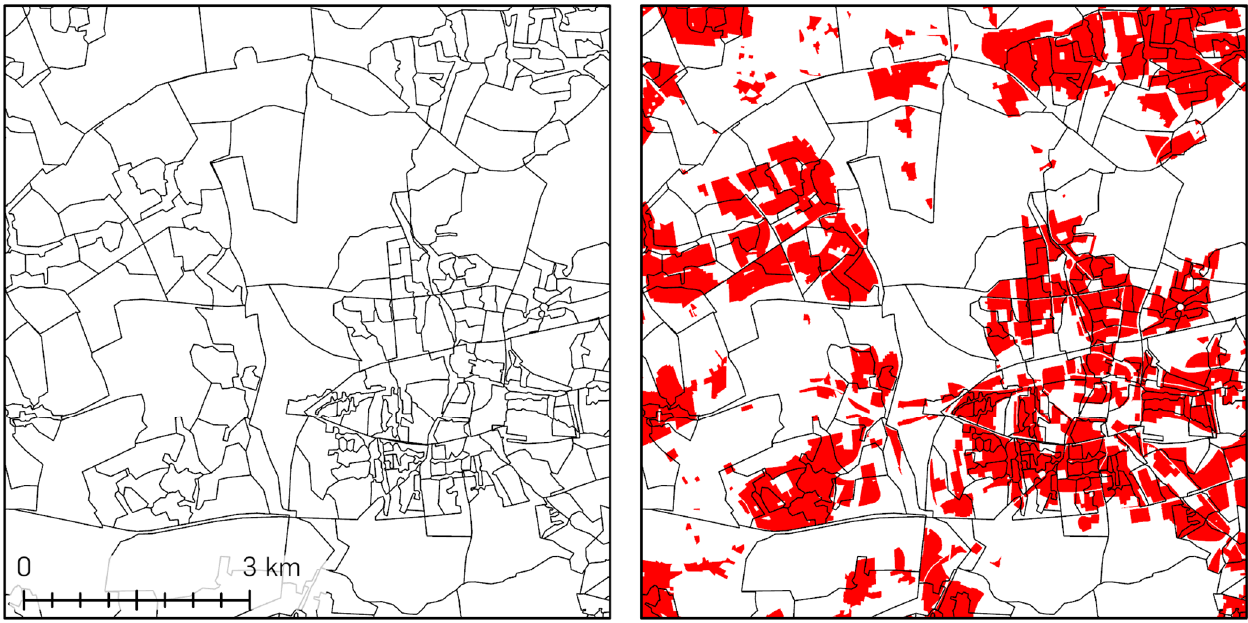
Figure 4. PLZ8 source polygons (black lines) and target polygons (red areas) (Data source: [22,30]).